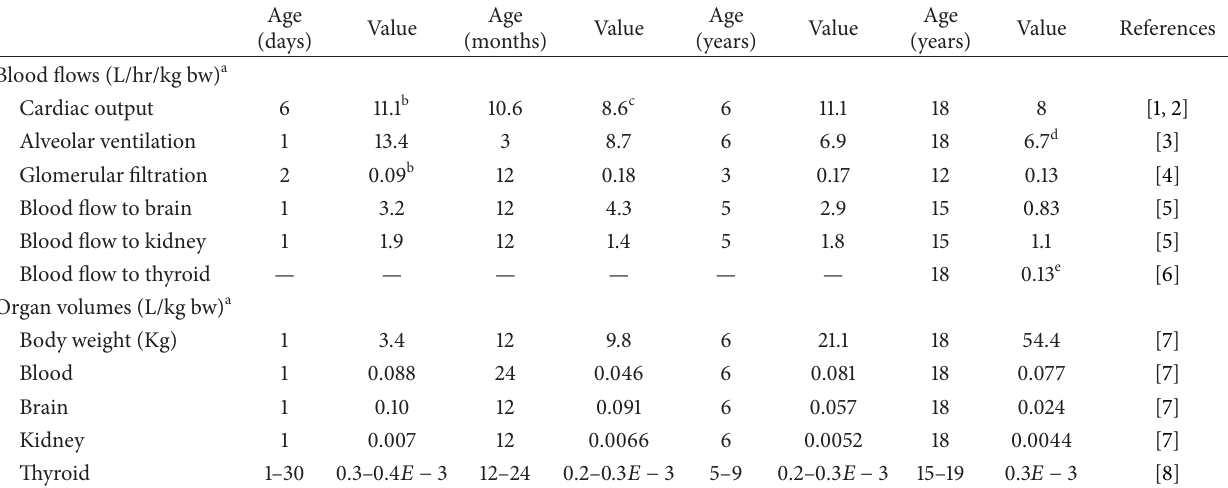
Table 1: Selected physiology values in infants, children, and young